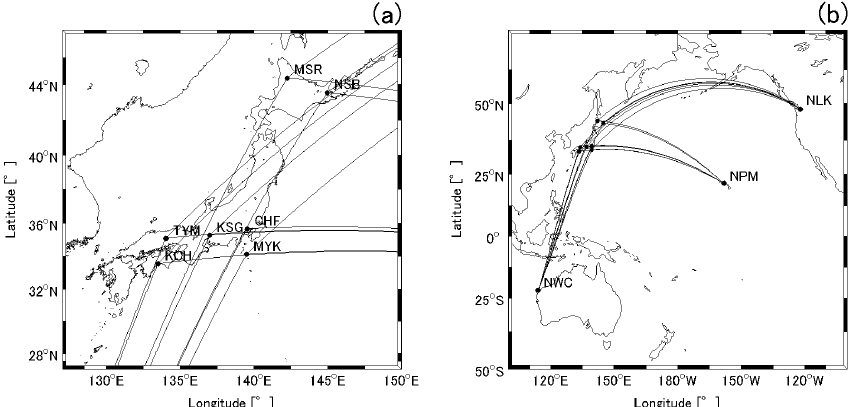
Figure 1. Maps showing the geographic locations of VLF transmitters and receivers used for the data analysis. Corresponding great circle paths (GCPs) for every transmitter–receiver pair are also given. (a) Paths around Japan (indicating VLF receiving stations) and (b) entire paths (including VLF transmitters).